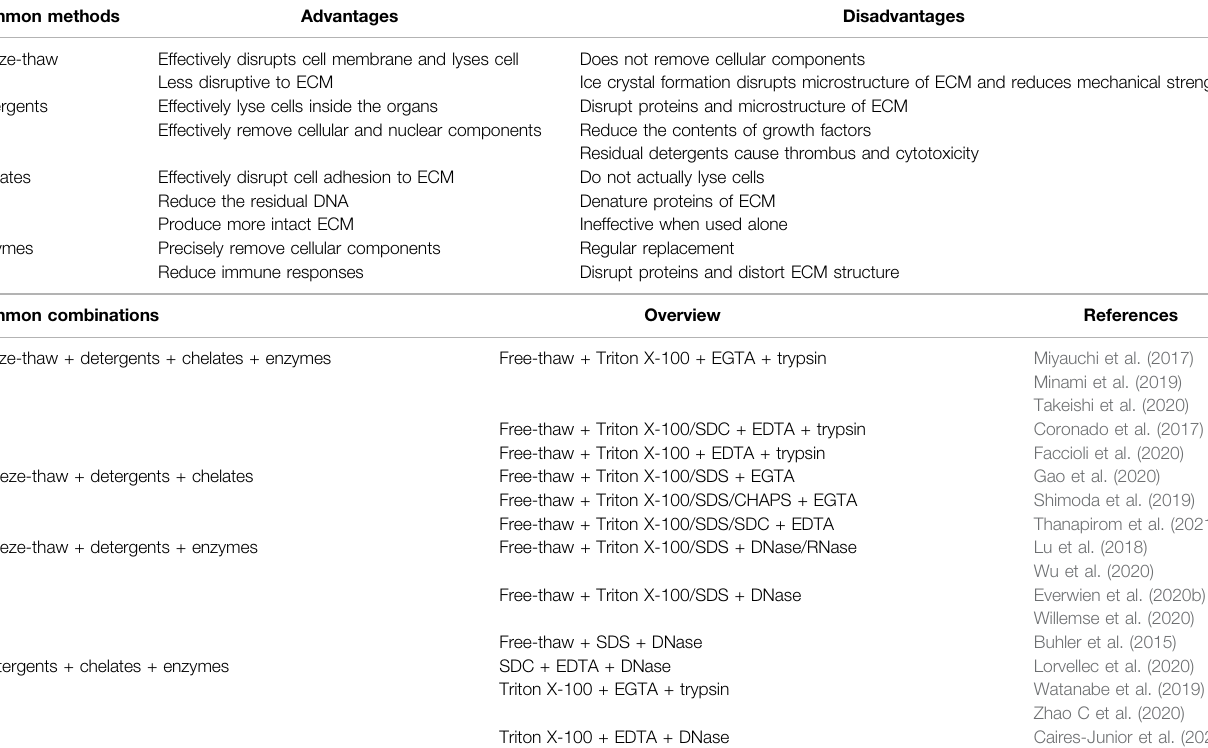
TABLE 1 | Common methods and combinations used in liver